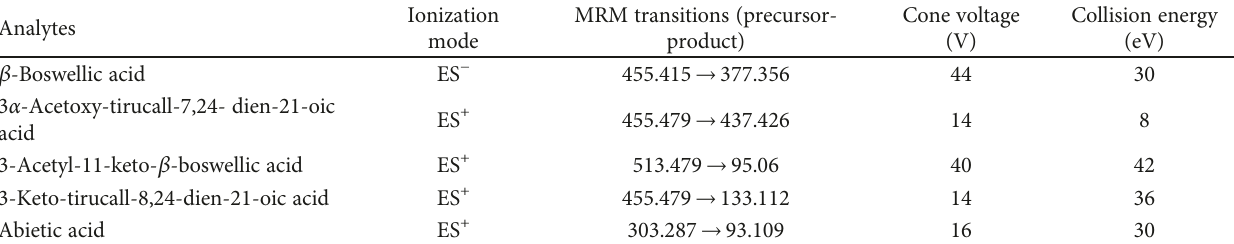
Table 1: The cone voltage and collision energy optimized for each analyte and selected